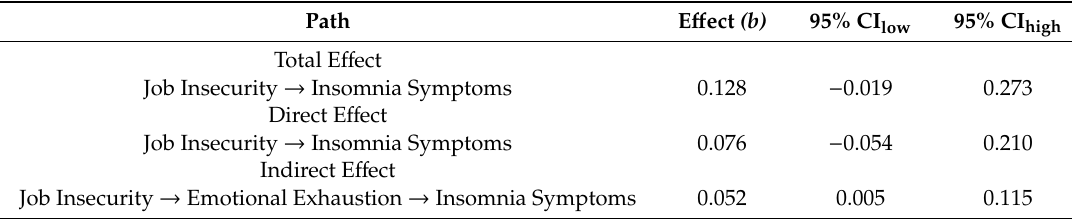
Table 3. Test of the mediation e ff ect of emotional